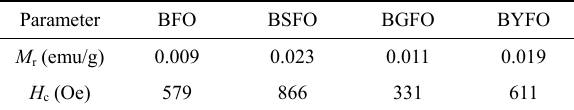
Table 3 Detailed magnetic parameters of pure